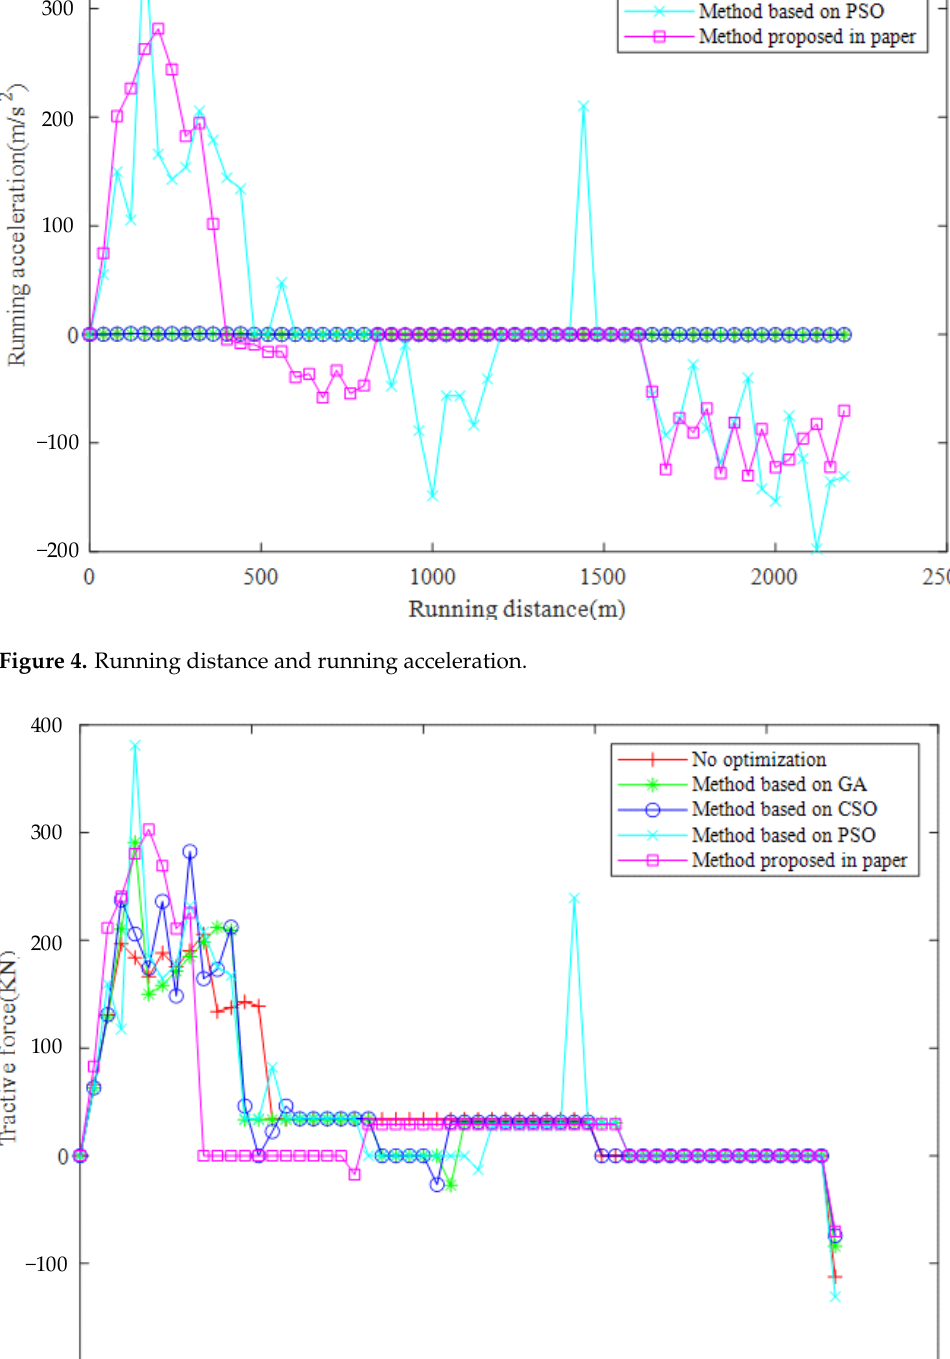
Figure 5. Running distance and tractive force.